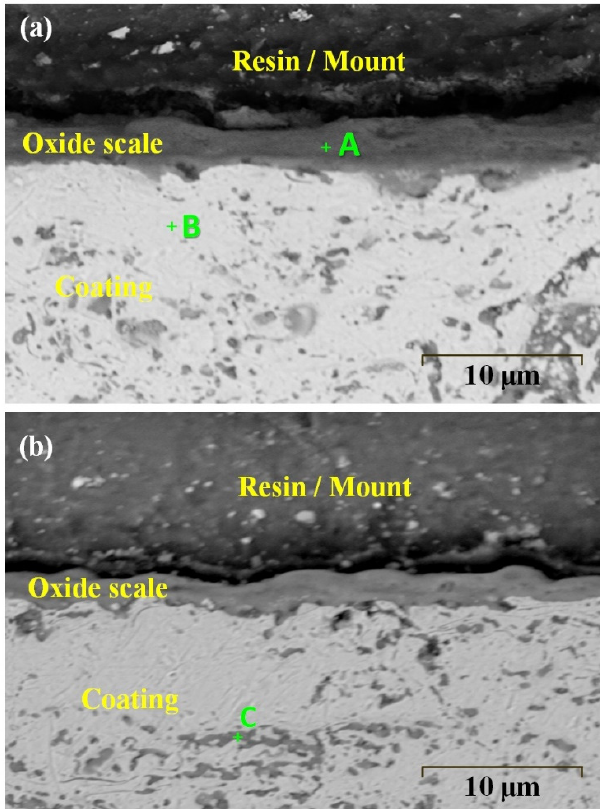
Figure 9. Cross-sectional FESEM micrographs of the oxidized ( a ) microcrystalline and ( b ) nanocrys- talline AlCrFeCoNi HEA coatings after 50 cycles of the cyclic oxidation process at 1100 °C. Table 4. The localized elemental percentage (wt.%) obtained by the EDS results for the selected regions marked in the oxidized micro- and nanocrystalline coatings (indexed in Figure 9a,b). Indexed Region